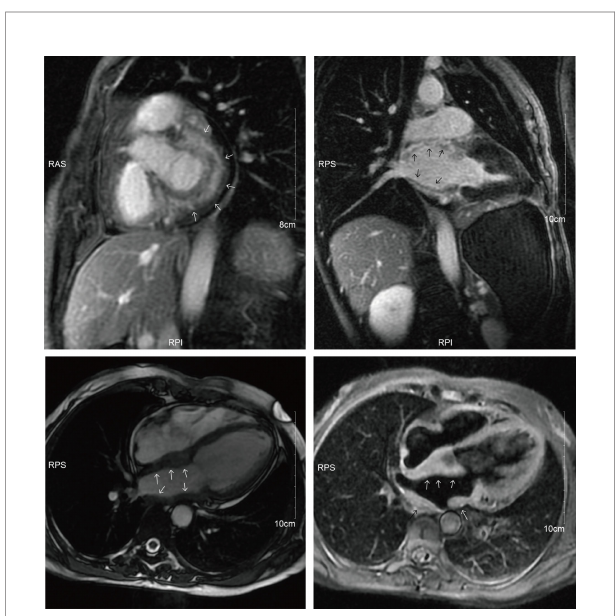
FIGURE 3 | CMR showed a signi fi cant thickening of the left atrial